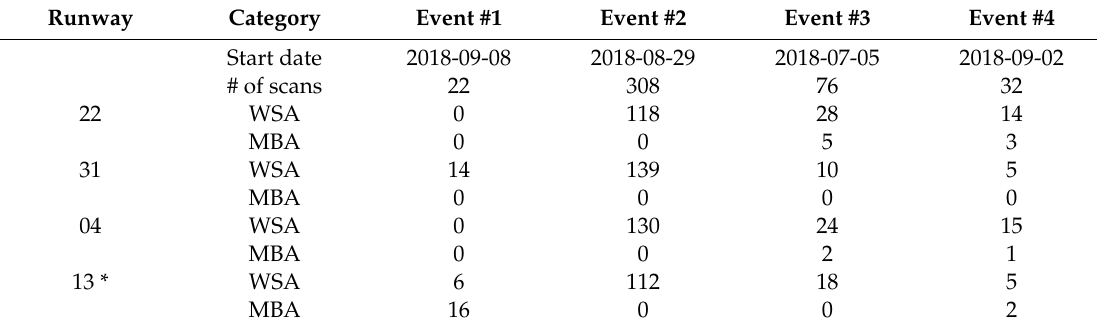
Table 2. Evaluation of the selected weather events (#1 − #4) from the perspective of lidar scans: how many times the given runway and its corresponding arrival corridor meet with at least one lidar beam